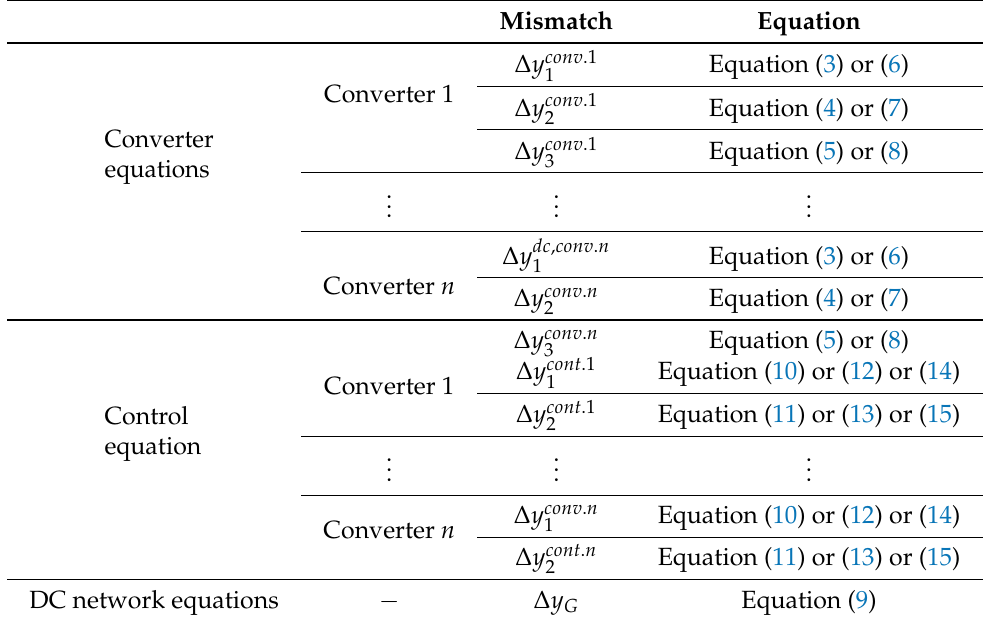
Table 1. Mismatch vector of equations in AC-DC Power Flow ( ∆ y